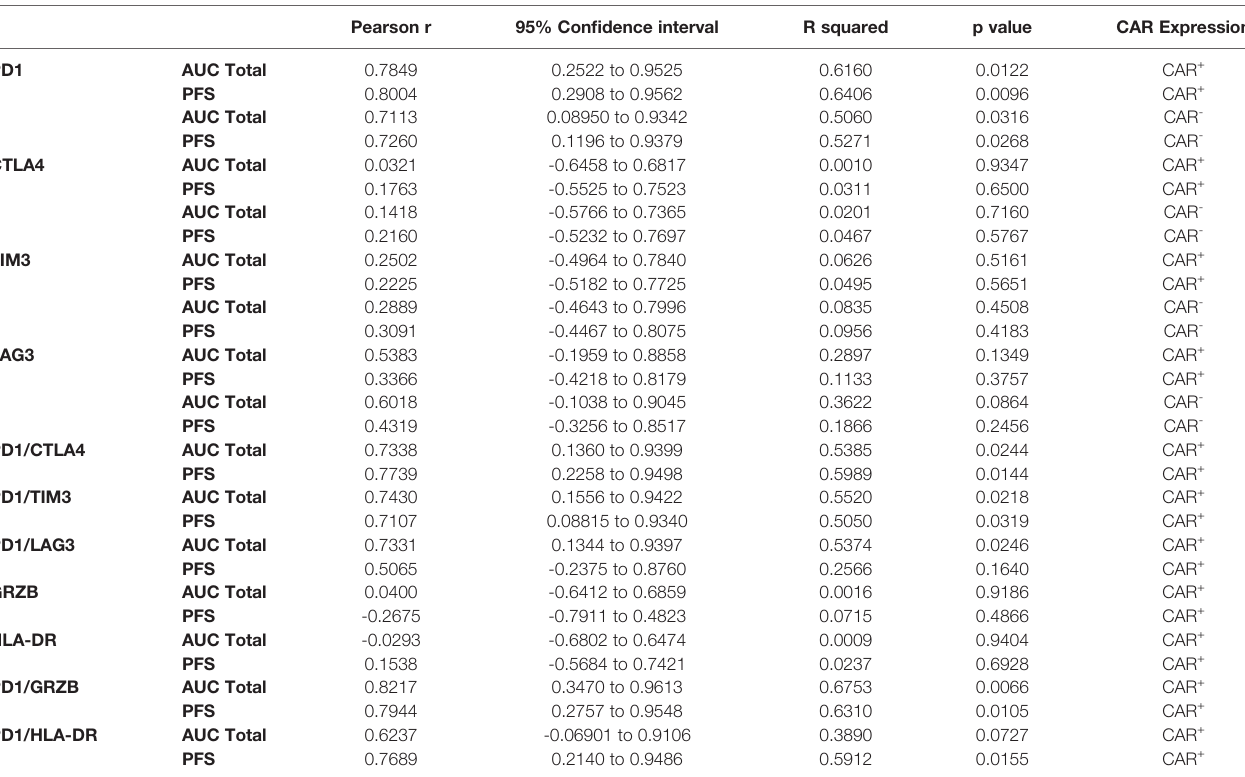
TABLE 1 | Summary values of CD4 + CAR + and CD4 + CAR - PD1/ICI and PD1/activation marker expression correlations in patient infusion products, associated with Figures 2 – 5 .